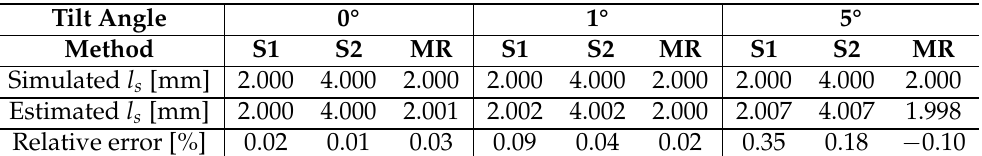
Figure 9. The relative error of sample column height calculation versus frequency for distilled water for ( a ) the perfectly vertical cell position, ( b ) 1° and ( c ) 5° tilted cell. Line colors: red—the outcome of the meniscus removal (MR) method, blue and yellow—Somlo’s method [15] for the initial (S1) and the final (S2) volumes of liquid, respectively. Table 3. Juxtaposition of simulated and estimated column heights of samples l s with their relative errors determined for distilled water for the different tilt of the cell and the methods used: S1, S2— Somlo’s method for the initial and final volumes of liquid, respectively, MR—the meniscus removal method for the incremental column height of the